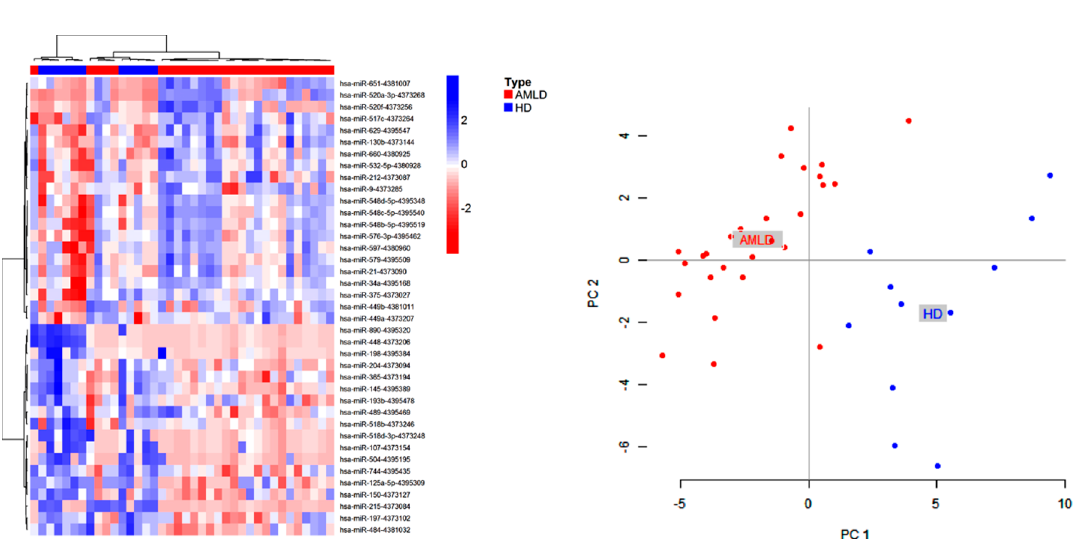
Figure 1. Di ff erentially expressed bone marrow circulating miRNAs in newly diagnosed AML patients compared to healthy donors. ( A ) Hierarchical clustering and heatmap of microRNA (miRNA) expression profile in acute myeloid leukemia (AML) ( n = 27) versus healthy donors ( n = 11). The list of miRNAs was filtered with a p -value < 0.005 and fold change ≤ 0.5 or ≥ 2. A total of 39 miRNAs (21 up- and 18 downregulated) were significant differentially expressed. The color key indicates centred and standardized miRNA expression levels (Z-scores). Upper color bar labels samples by baseline diagnosis. ( B ) Principal Component Analysis (PCA) showing the grouping of AML patients (red) and HD (blue) based on the 39 DEmiRNAs profile.